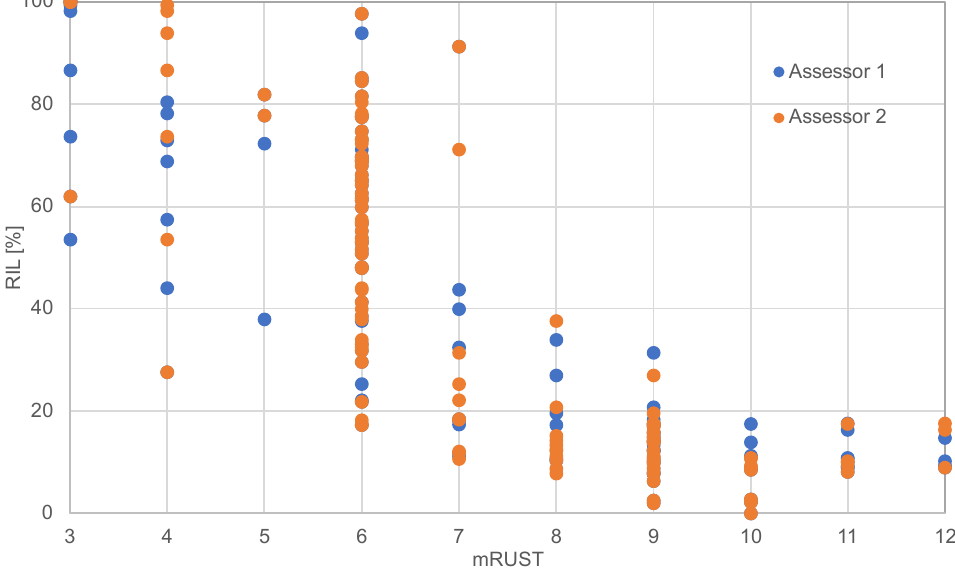
Figure 6. Correlation between radiographic scoring (mRUST) and relative implant load (RIL) for two assessors. Eight animals included (519,042–520,001).